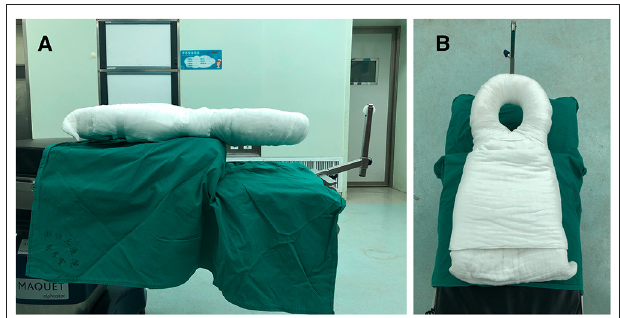
FIGURE 1 | The assembly of traction system set on a conventional operating table and the body-shape plaster bed as seen from different positions (A,B) . The body-shape plaster bed with skull traction (BSPST) position system can provide enough space for managing anesthesia tube.